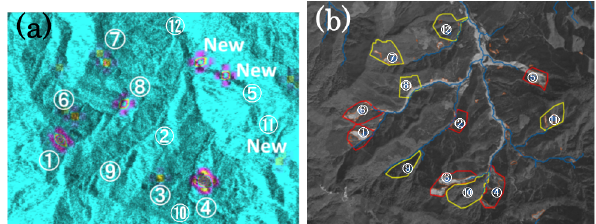
Figure 2. (a) The interferogram around the Wanitsuka Mountains in the Miyazaki Prefecture (ALOS/PALSAR data acquired from 2006 to 2011). (b) Collapsed area (red) and uncollapsed area (yel- low) was interpreted based on aerial photographs acquired from 1946 to